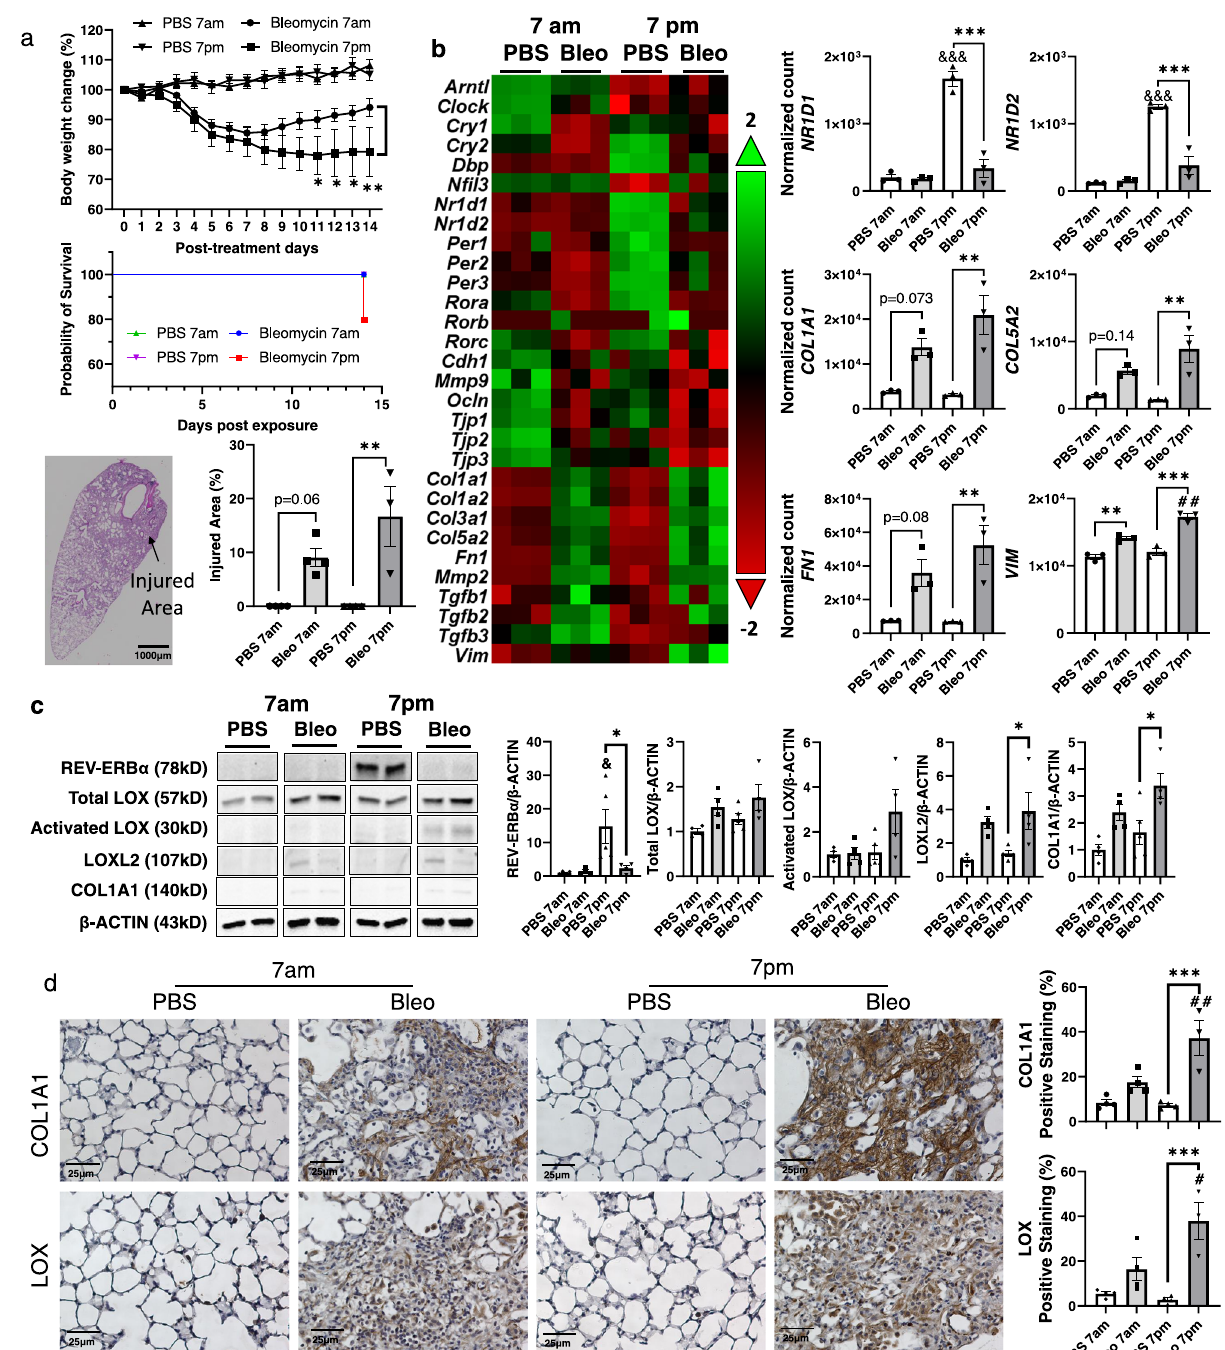
Fig. 3 | The health status of mice, circadian genes and fi brotic genes and pro- tein expressions were affected by bleomycin injury in different time points (7 a.m. vs. 7 p.m.). C57BL/6J WT female mice were used for testing. a The body weightsandsurvivalrateweremonitoreduntilday14post-injury.( n =3 – 5miceper group,* p <0.05,** p <0.01vs.bleomycin7a.m.group).Lungswereharvested,and H&E staining was performed to identify the injured area percentage. b RNA was isolated from lungs homogenates, and gene expression analysis was conducted using customized nanostring panel through nCounter SPRINT Pro fi ler, and tran- scripts levels were normalized and visualized by nSolver software. The dysregu- lated genes were shown as a heatmap with circadian and pro fi brotic genes. Selected gene expressions were shown as bar graph ( n =3 mice per